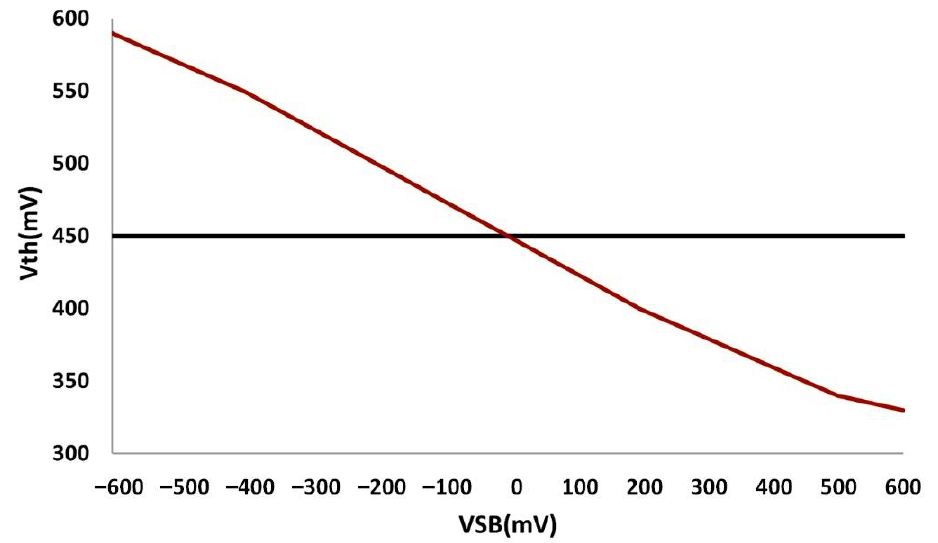
Figure 12. V T -V SB (The red color refers to DTMOS and the dark blue to BTMOS).